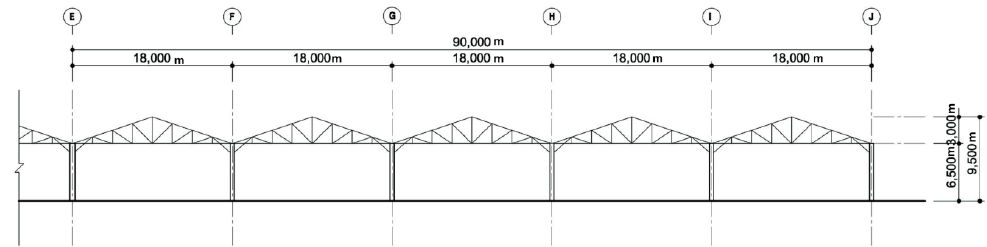
Figure 8. Plan and Picture of Case Study Building.